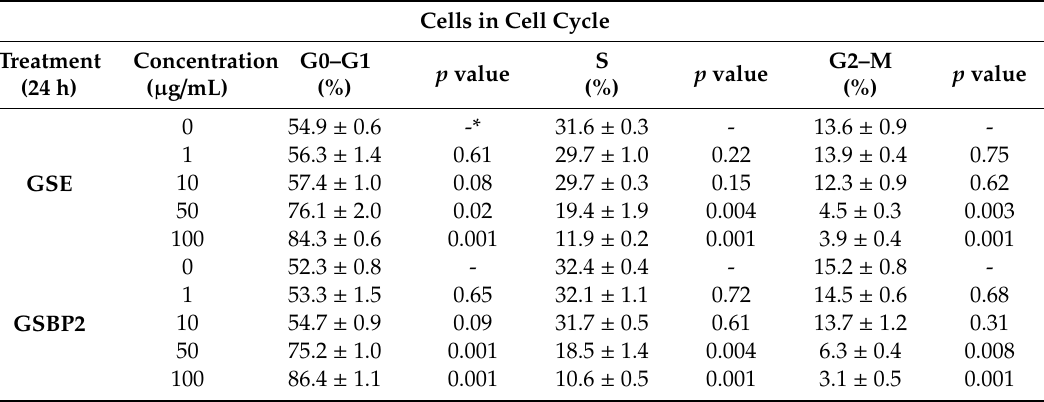
Table 1. DNA content analysis by FACS in KGN cells in response to various concentrations of GSE and GSBP2 ( n = 3 independent experiments). The mean of percentage of cells in each cell cycle stage (G0–G1, S, and G2–M) ± SEM is shown. In response to each treatment (GSE and GSBP2), the p value is indicated as compared to the control (no GSE or GSPB2 treatment) in each stage of cell cycle. Cells in Cell Cycle Treatment Concentration (24 h) ( µ g / mL)